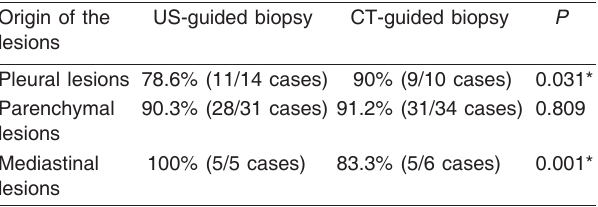
Table 2 Patients’ distribution according to their final diagnosis in the two studied groups